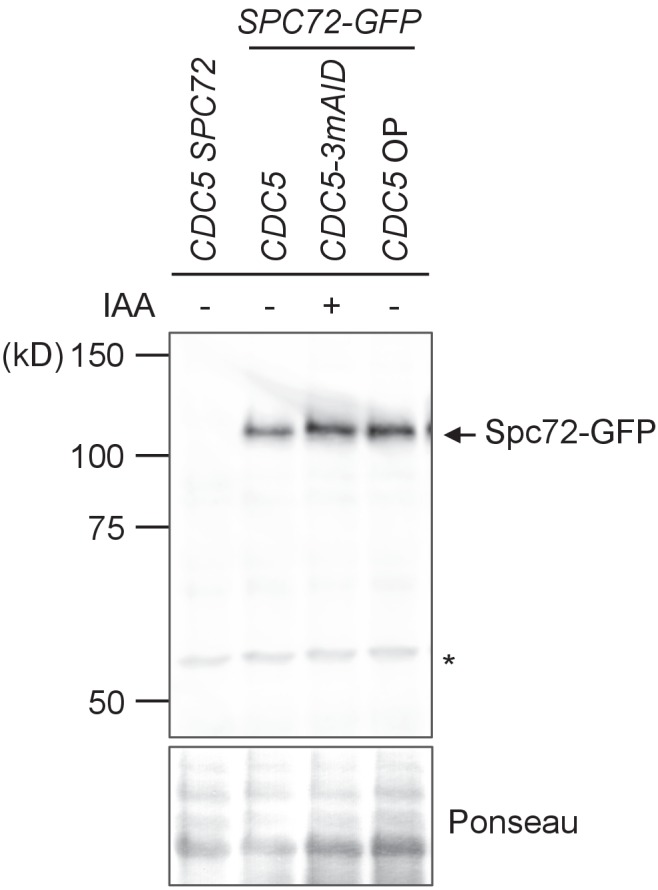
Spc72-GFP protein level was not affected by CDC5 overexpression.Logarithmically growing wild type (HPH1394), CDC5-3mAID (HPH1380), PTEF1-CDC5∆53 (HPH1542) with SPC72-GFP as well as wild type control cells (HPH448) were grown in YPDS medium. IAA was added and incubated for 90 min prior to cell harvest of HPH1380. Total cell extracts were analysed in a polyacrylamide gel followed by immunoblotting using anti-GFP antibody.